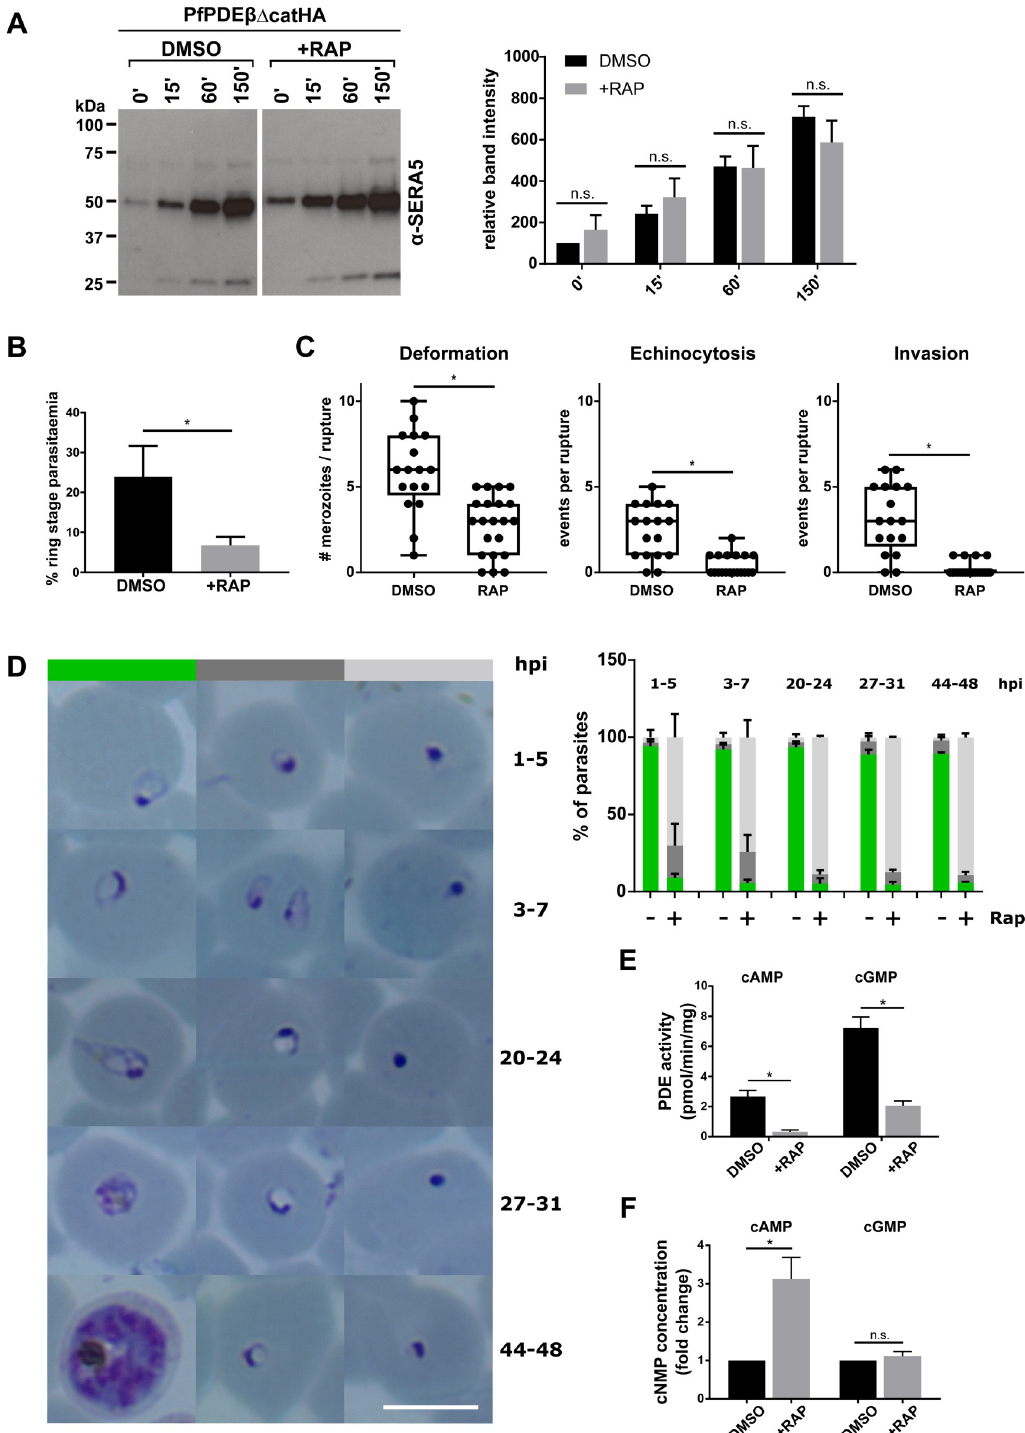
Fig 4. PfPDE β disruption leads to a severe invasion defect and rapid post-invasion death due to elevated parasite cAMP levels. (A) Western blot analysis of culture supernatants from cycle 0 RAP-treated or DMSO-treated PfPDE β Δ catHA schizont cultures over time. Supernatant samples were taken at the indicated times (minutes) following schizont purification. The blot was probed for the soluble PV protein SERA5, a biomarker of merozoite egress. A quantification of band intensities from three independent experiments is shown to the right. Analysis was performed using ImageJ software and values normalised to the DMSO start sample (0’). Means are presented, with error bars representing the standard error of the mean. No